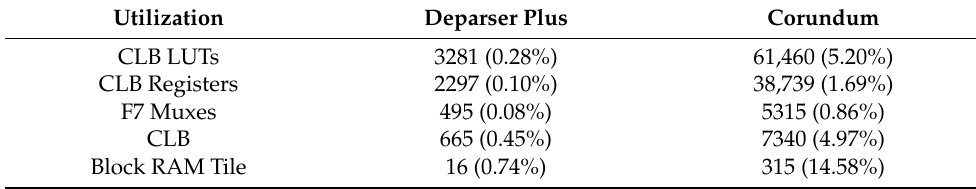
Table 4. Resource utilization of VCU118 FPGA.